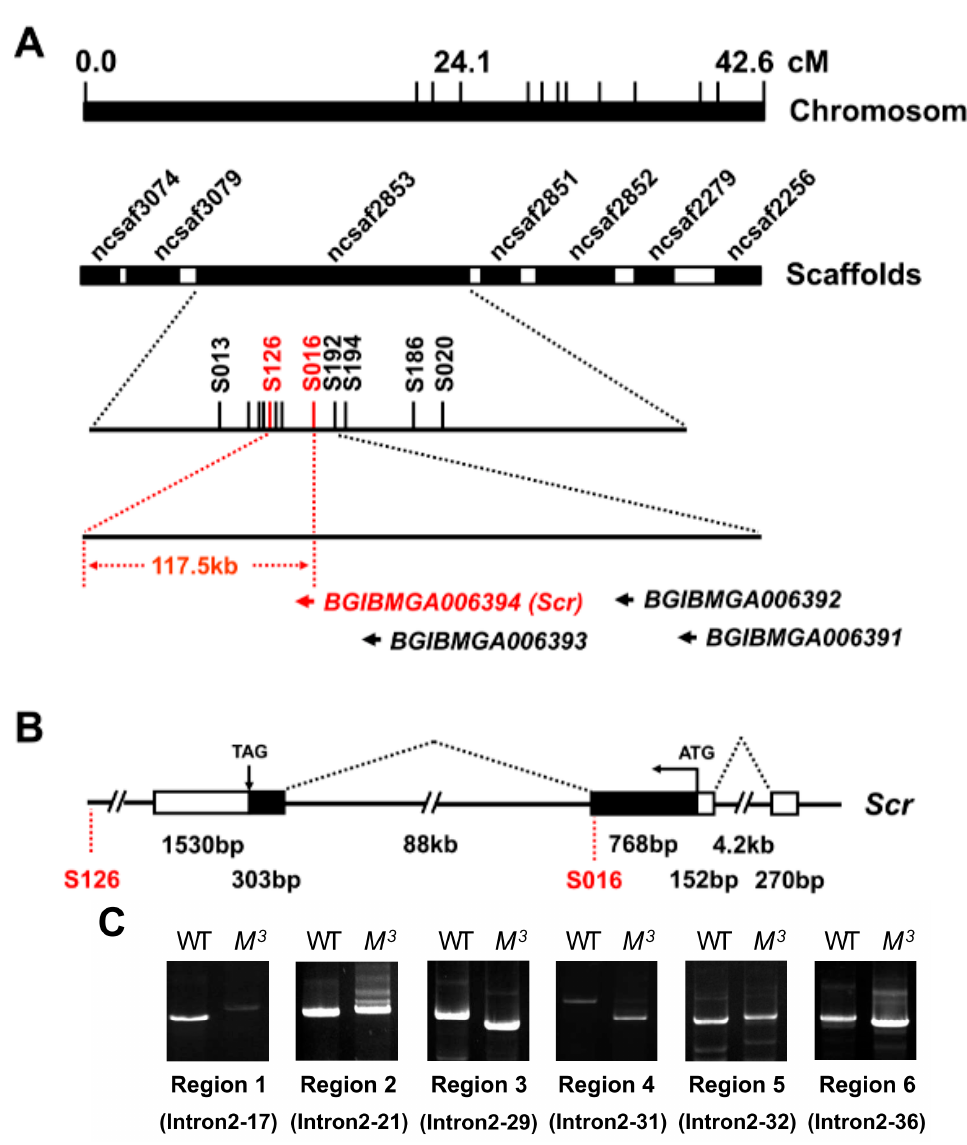
Figure 4. Positional cloning of the M 3 locus. ( A ) Positional mapping of the silkworm M 3 locus on chromosome 6. Using SNP markers on chromosome 6 and 1307 BC1 trimolting individuals, the region linked to the M 3 locus could be narrowed down to the 117.5 kb genomic region between SNP markers S126 and S016 on the scaffold of nscaf2853. Only one predicted gene, BGIBMGA006394 , was located in this region, and this gene is annotated as Scr ; ( B ) Schematic structure of the Scr gene. By searching the silkworm genome databases SilkDB and KAIKObase, the full-length cDNA sequence of the candidate Scr gene was determined to be comprised of three exons and two introns, and the second intron and the third exon are located in the genomic region that is linked to the M 3 locus. The black boxes, white boxes, and dotted diagonal lines indicate coding sequences, UTRs, and introns, respectively; ( C ) Genomic differences in intron 2 of the Scr gene between the M 3 and WT strains. Genomic PCR analysis confirmed that six regions in intron 2 of the Scr gene exhibited sequence variations of greater than 100 bp in length between the M 3 and WT strains. The names of the primers used for amplifying these regions are presented in